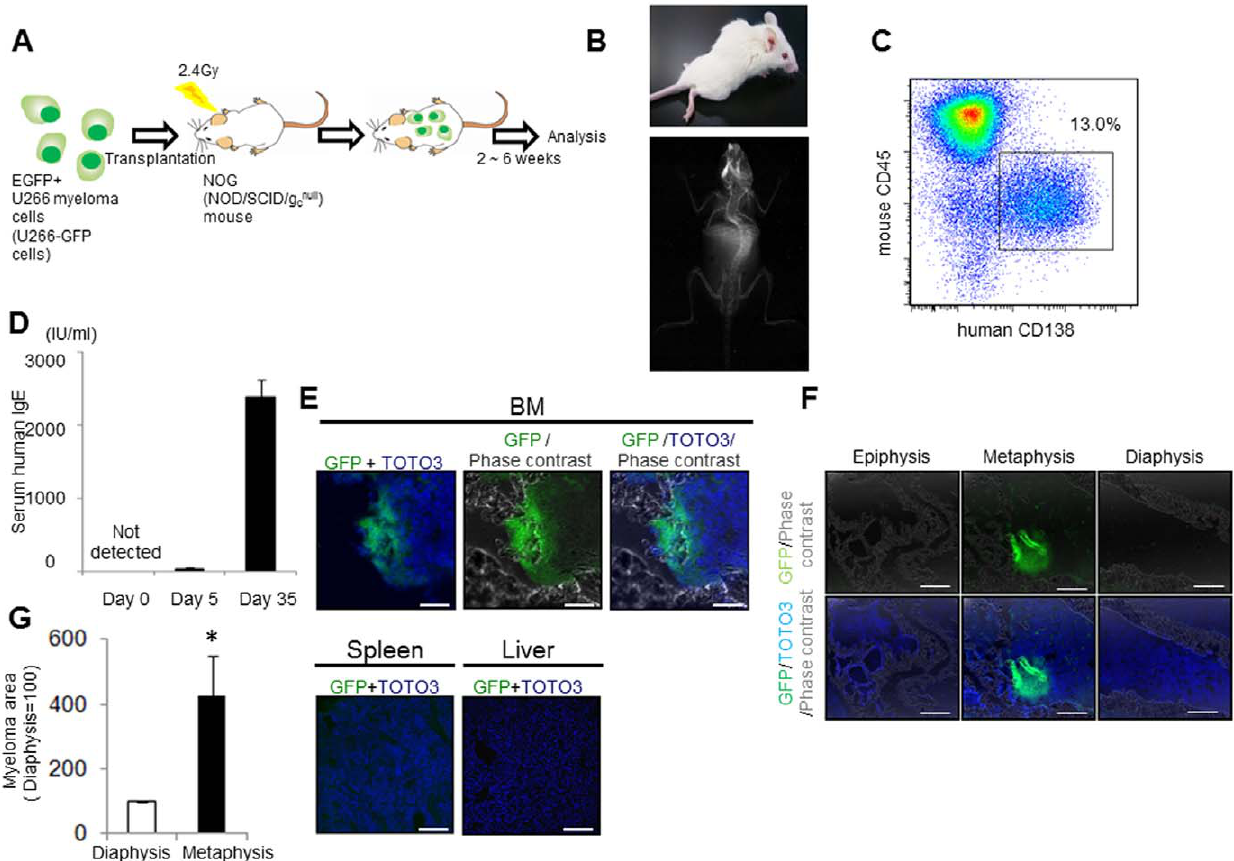
Figure 1. Interaction between multiple myeloma cells and the niche in an invivo human myeloma model. A. Study design of the NOG- hMM model. Two million EGFP + U266 myeloma (U266-EGFP) cells were intravenously inoculated into 2.4 Gy irradiated NOG (NOD/SCID/g cnull ) mice. Two to six weeks after transplantation, mice were sacrificed for analysis. B. Representative clinical manifestation (upper panel) and radiologic examination (lower panel) of mice 4 weeks after transplantation. All mice showed hind leg paralyses (left) associated with spinal compression fractures (left; arrow). This clinical manifestation was observed in more than 20 mice. C. Representative FACS plot of U266-EGFP cell-transplanted NOG mice. Bone marrow of NOG mice was analyzed by FACS 4 weeks after U266-EGFP cell transplantation using anti-human CD138 antibody and anti-murine CD45 antibody. The experiment was performed in more than forty mice with similar results. D. Serum levels of human IgE. Human IgE levels in the serum of NOG mice at 0 (non-transplanted, non-irradiated mice), 5 or 35 days after transplantation with U266-EGFP cells were analyzed by ELISA (n=3–5, mean 6 SD). The experiment was performed twice with similar results. E. Double immunohistochemistry (IHC) of EGFP (green) and TOTO3 (blue) of the BM (upper panels), spleen or liver (lower panels) at 2 weeks after transplantation. U266-EGFP cells engrafted only in the BM. Representative data from 10 to 20 fields from the BM of two mice from three independent experiments are shown. Bars=200 m m. F. Immunohistochemical (IHC) analysis of EGFP (green) and TOTO3 (blue) at the anatomical region of long bones at the early stage. Representative data from 10 to 20 fields from the BM of two mice from three independent experiments are shown. Bars=200 m m. G. Quantification of U266-EGFP cells at the diaphysis and the metaphysis of the long bones. U266-EGFP at the metaphysis regions is represented relative to the diaphysis region (diaphysis=100, n=3, mean 6 SEM). The experiment was performed twice with similar results.